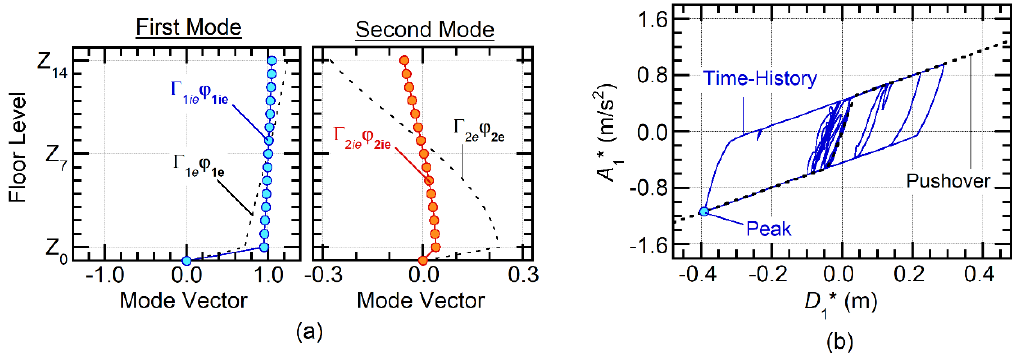
Figure 9. Evaluated mode vector at the peak response and first modal response of Model-14 (Art-S03, 100%): ( a ) shape of the first and second mode vectors at the peak response and ( b ) comparison of the relationships of A 1 * versus D 1 * calculated from the nonlinear time-history analysis and pushover analysis results.